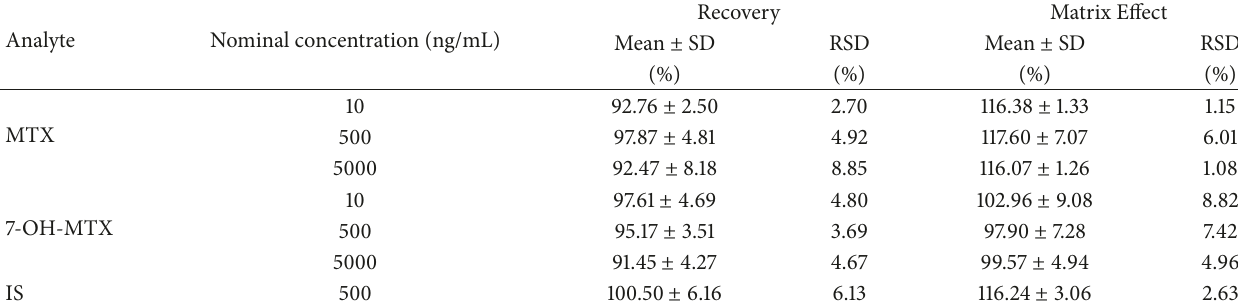
Table 1: Recovery and matrix effect for the analytes in human plasma (n=3). Analyte